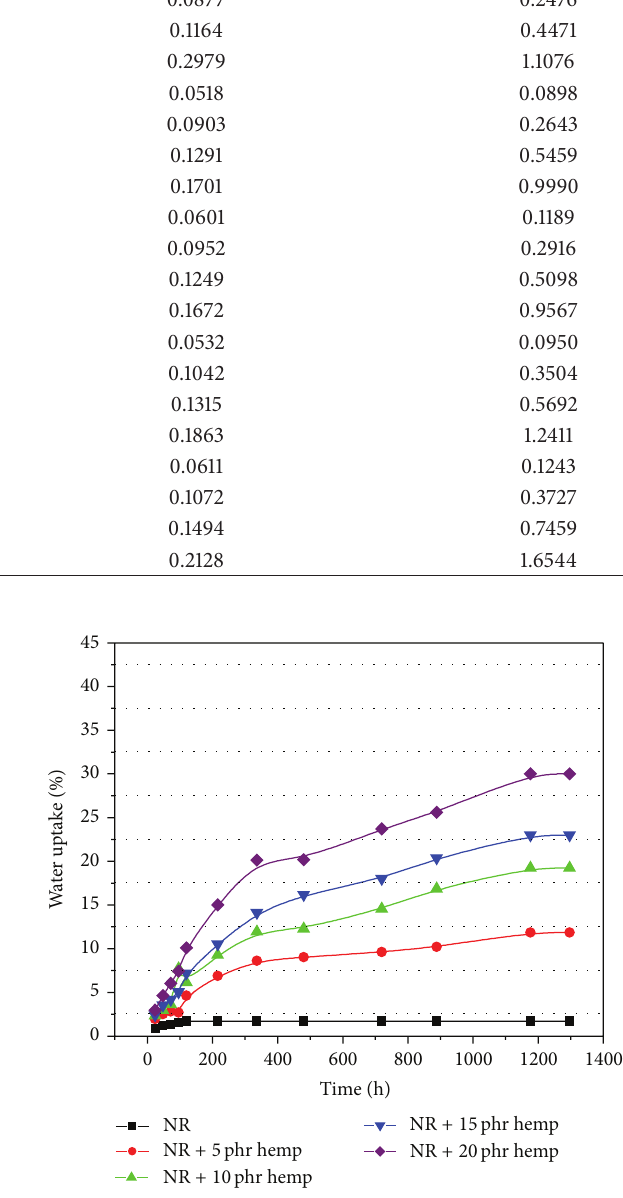
Figure 8: Water uptake of polymeric composites at absorbed dose of 150